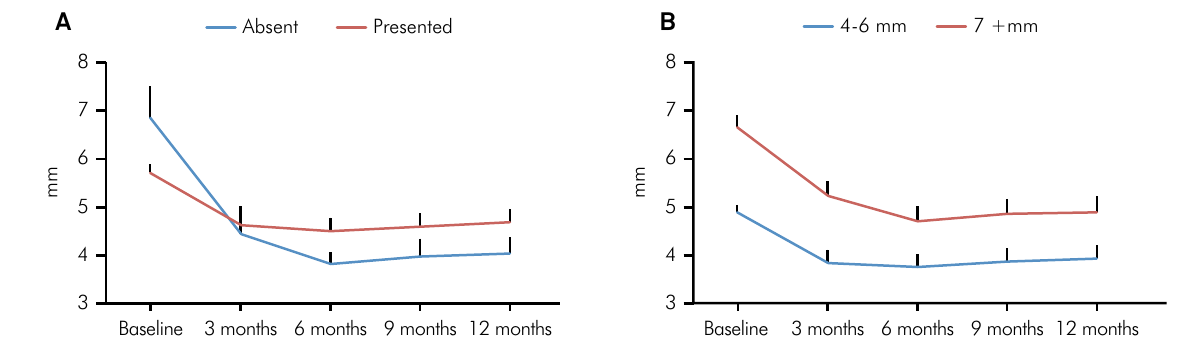
Figure 3. Clinical attachment level over 12 months, according to different predictors (a: visible plaque; b: baseline